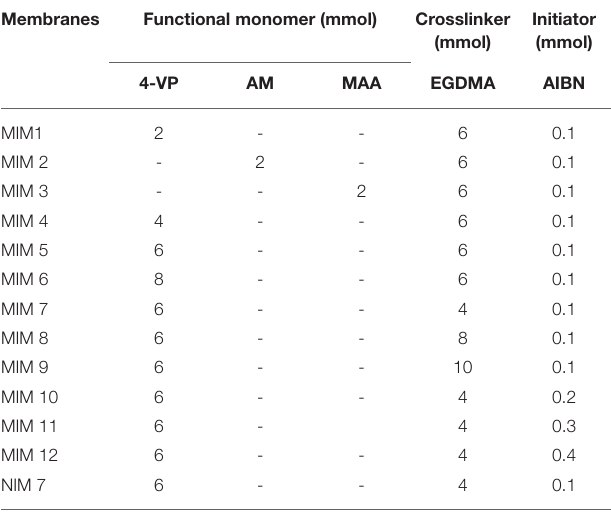
TABLE 1 | The preparation parameters of molecularly imprinted membrane. Membranes Functional monomer (mmol) Crosslinker